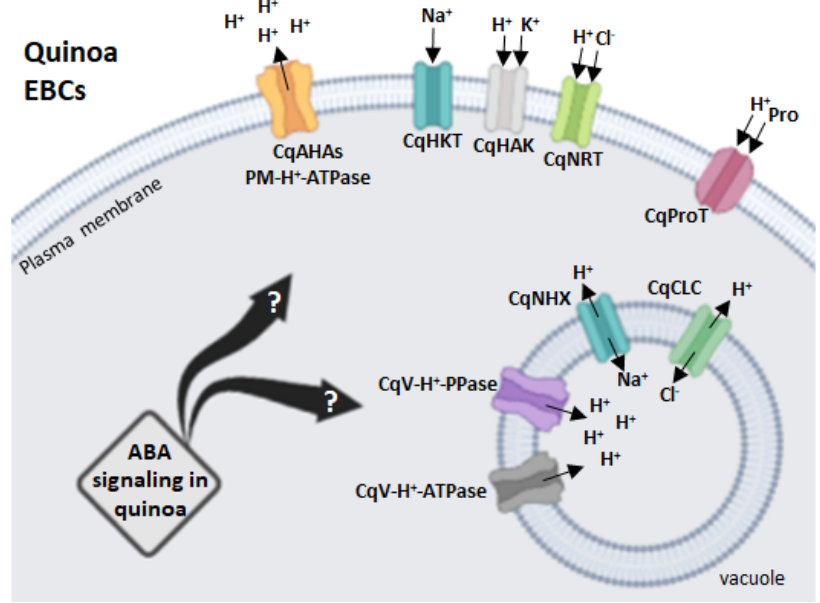
Figure 2. Potential transmembrane targets of ABA signaling in quinoa EBCs. CqHKT channels mediate Na + transport into EBCs. CqNHXs and CqCLC operate as antiporters of Na + /H + and Cl − /H + , respectively. Potassium, chloride, and compatible osmolytes, such as proline (Pro), are transported into the sink cells by H + symporters (CqHAK, CqNRT and CqProT, respectively). Plasma membrane H + ATPase (CqAHAs/PM-H + -ATPase), vacuolar H + ATPase (CqV-ATPase), and vacuolar CqV ‐ H + ‐ PPase generate the proton motive force required for ions and solutes transport from apoplast to bladder cells cytoplasm, and then to the tonoplast. Icons were obtained from Biorender.